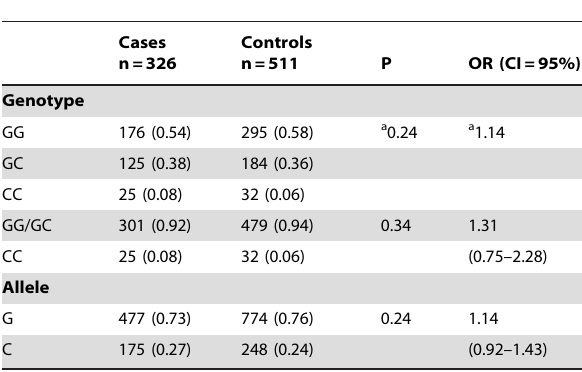
Table 1. Case-Control study of IL-6 –176 (G . C)